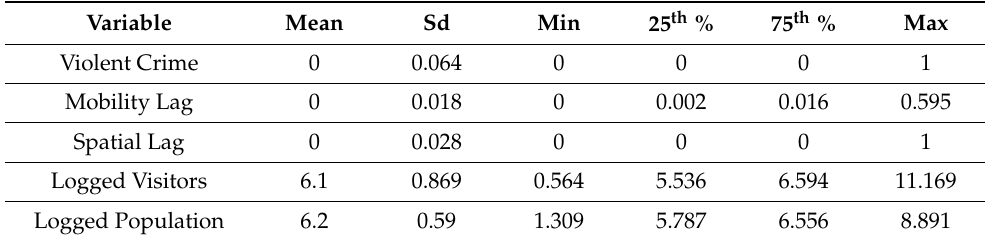
Table 3. Summary statistics for